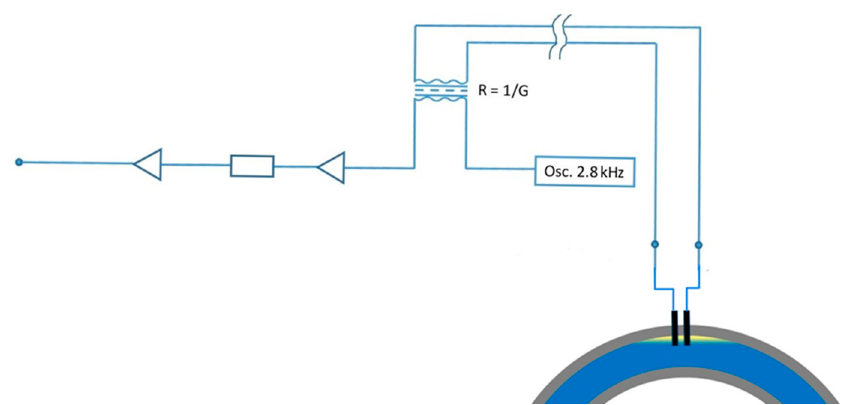
Figure 7. Principle of operation for conductivity measurement. Lower density displaced fluid (yellow) stratified above higher density displacing fluid (blue).